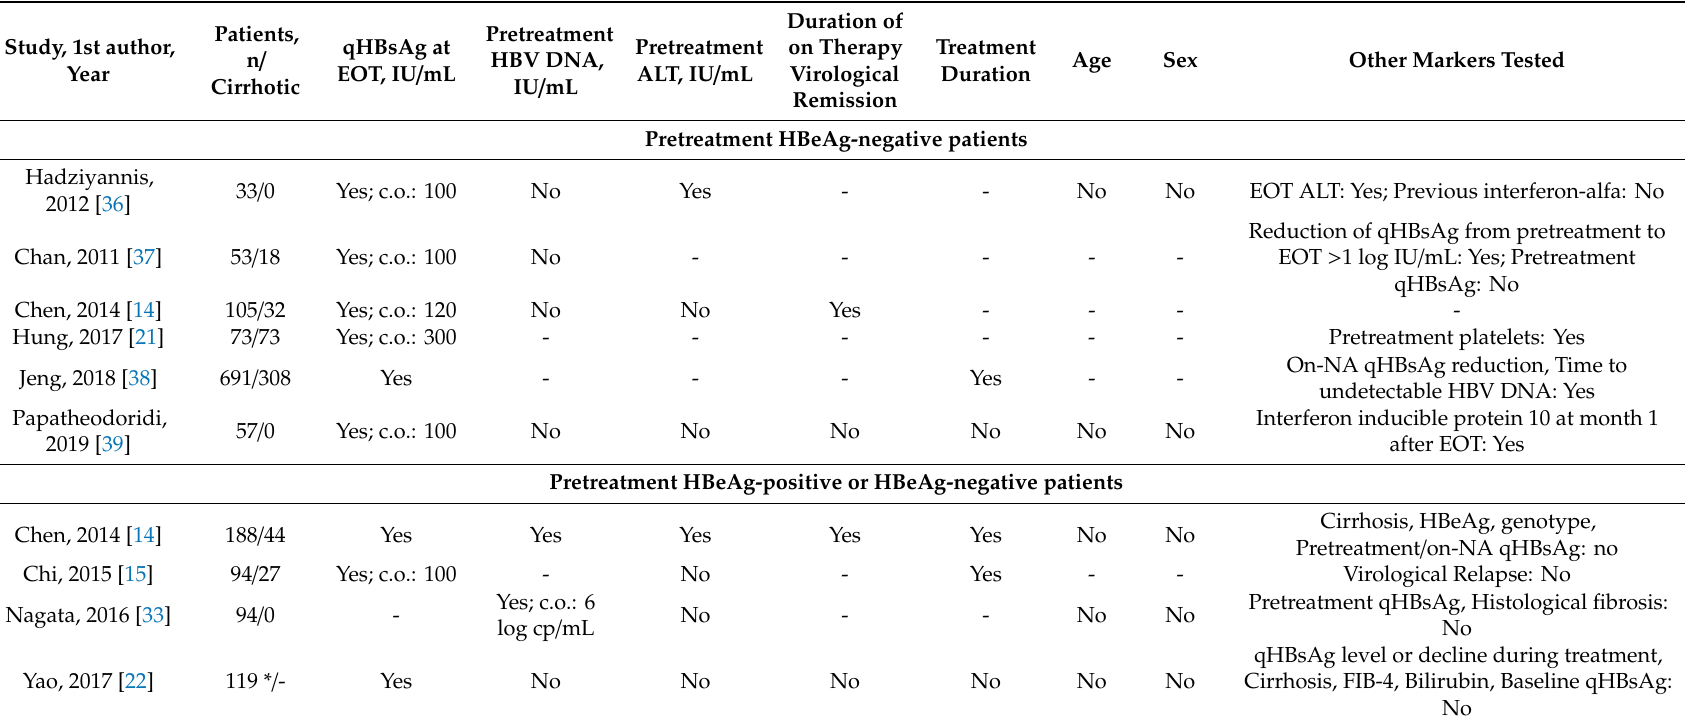
Table 3. Predictors of HBsAg loss after discontinuation of nucleos(t)ides analogues (NAs) in studies including chronic hepatitis B (CHB) patients who remained HBsAg positive at the end of therapy (EOT). Predictors are provided separately for pretreatment HBeAg-negative patients, when available, or mixed pretreatment HBeAg-positive or HBeAg-negative patients when separate analyses were not